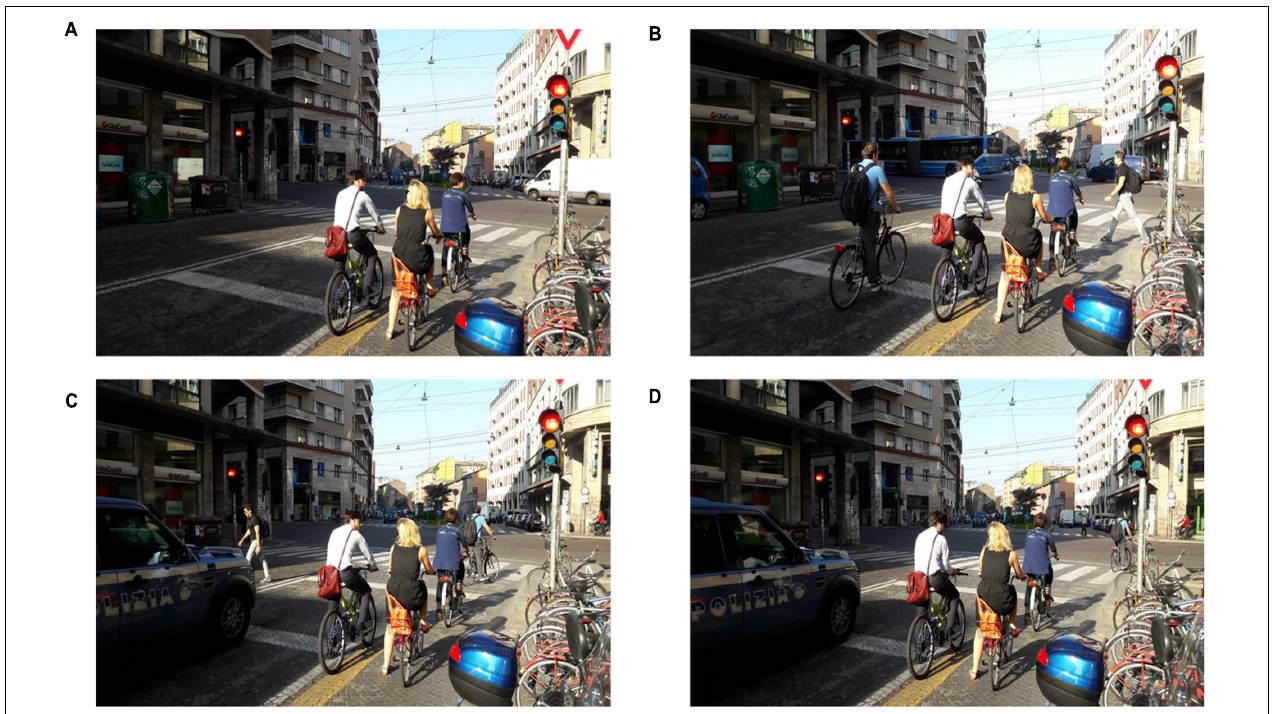
FIGURE 1 | A cyclist violating the red-light in an observation site. Photo (A) top left; photo (B) top right; photo (C) bottom left; photo (D) bottom right.